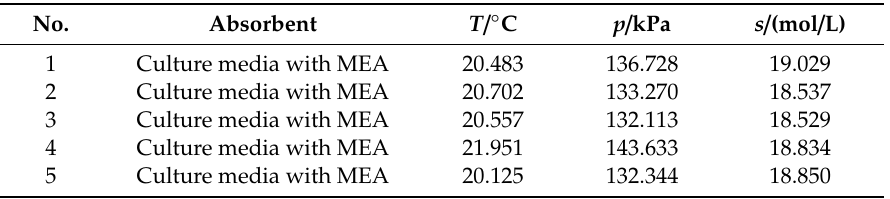
Table 5. Process optimization for CO 2 absorption by